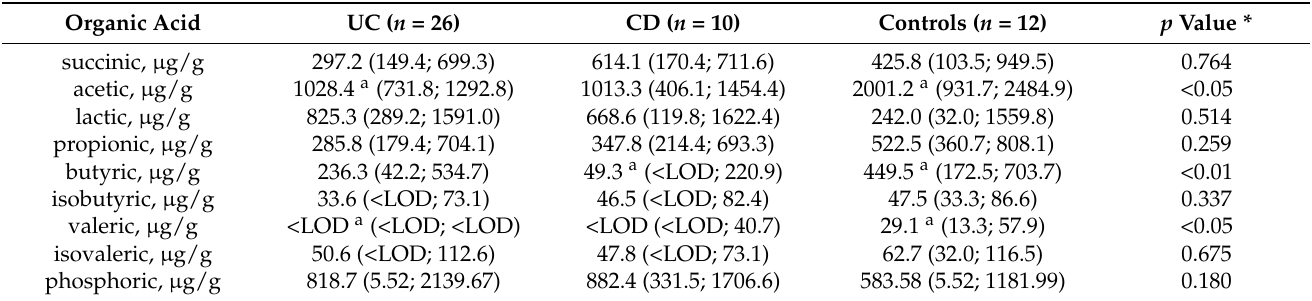
Table 2. Concentrations of organic acids in patients with ulcerative colitis (UC), Crohn’s disease (CD), and